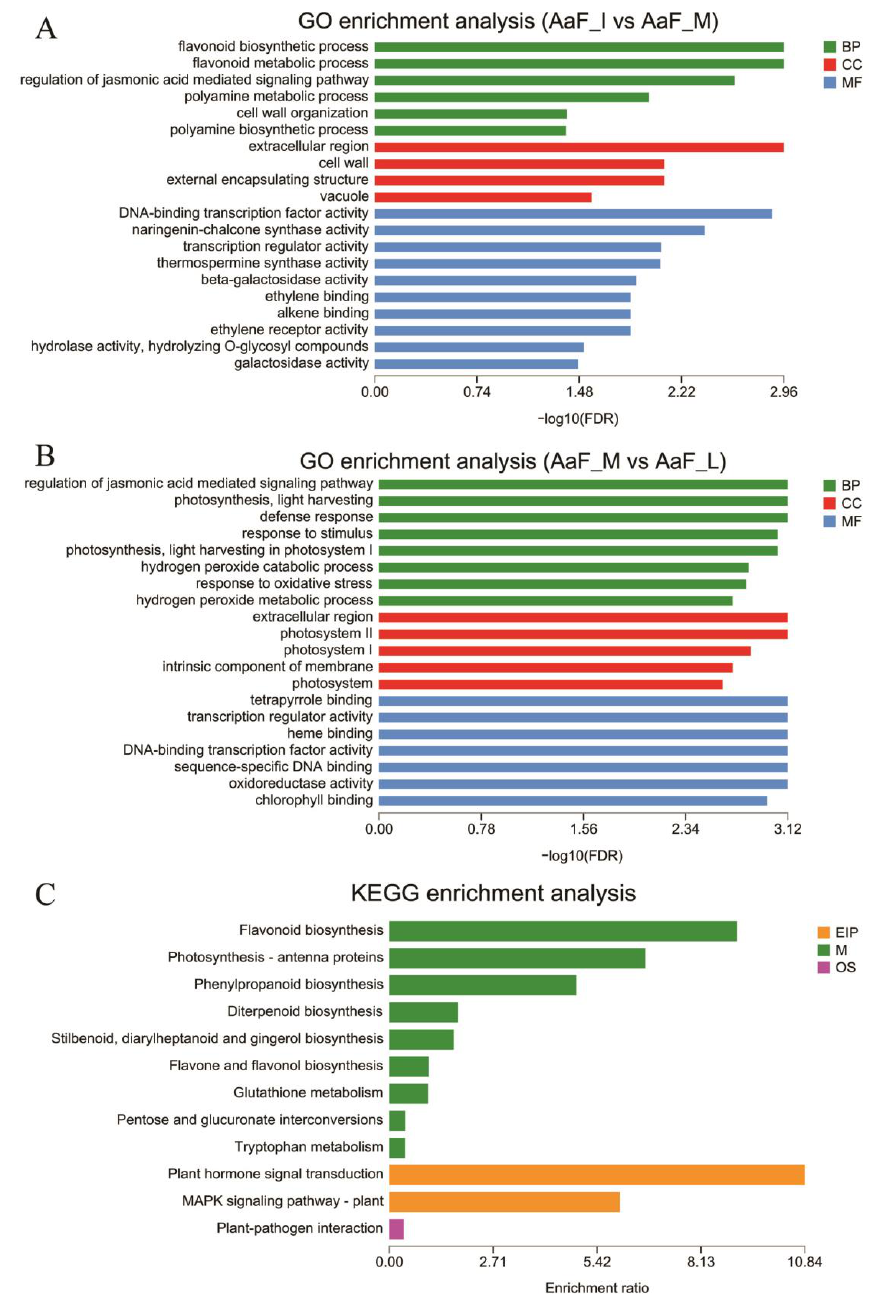
Figure 3. Functional classification of differentially expressed genes. ( A ) GO term enrichment analysis of DEGs between AaF_I and AaF_M. ( B ) GO term enrichment analysis of DEGs between AaF_M and AaF_L. ( C ) KEGG enrichment analysis of DEGs. Enrichment analysis used Fisher’s exact tests, and each bar represents a term or a